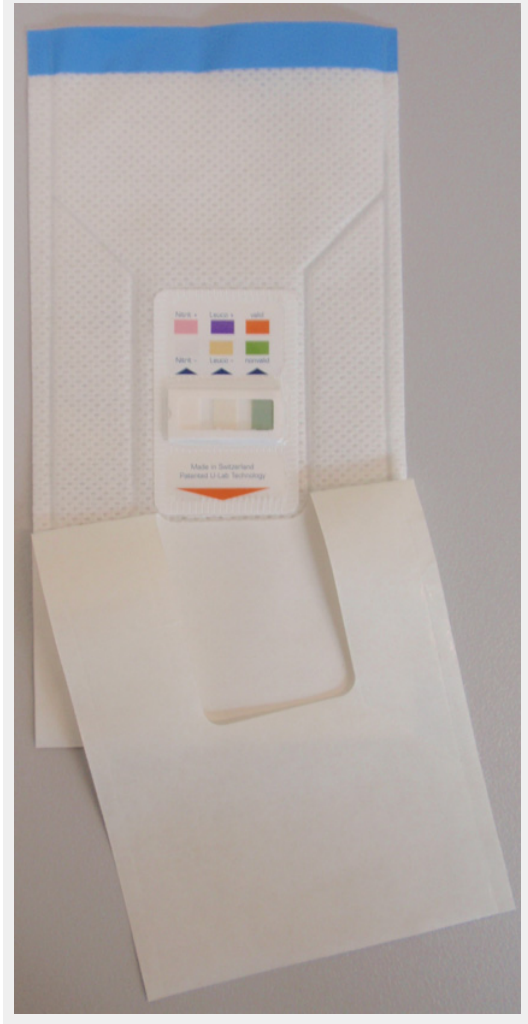
The front side of U-Test ® facing the patients’ body is shown on the left side. On the right side the back side of U-Test ® is shown with the adhesive tape serving to fix the device into the baby’s